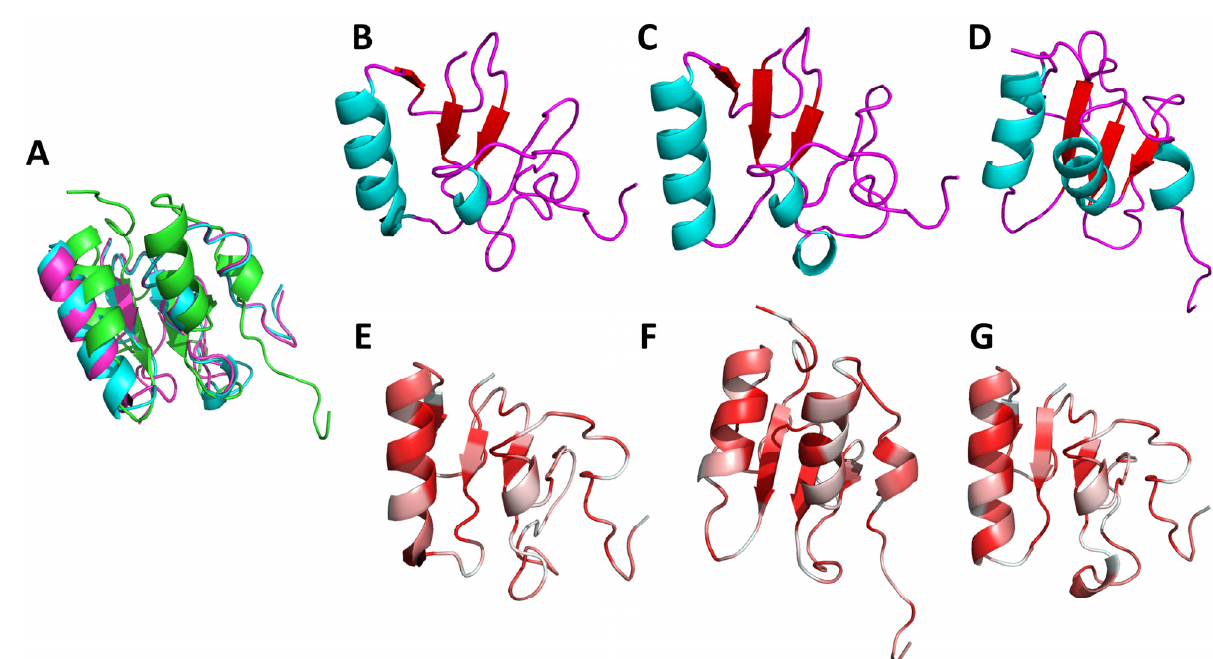
Figure 2. Selected Lmj_04_BRCT models secondary structure and hydrophobic regions. Ribbon representation of ( A ) aligned models (green: SwissModel_2, pink: Mult1_lig, cyan Mult1_lr); ( B ) Mult1_lig; ( C ) Mult1_lr; ( D ) SwissModel_2. Colors represented secondary structure elements: Red: β -sheets. Cyan: α -helixes. Pink: loops. Usual BRCT hydrophobic core of β -sheets trapped between α -helixes in a β 1, α 1, β 2, β 3, α 2, β 4, and α 3 disposition is only moderately represented in the constructed models as only the Mult1_lr model folded into these expected β 2 sheet and α 2 helix whereas expected β 4 was only present in SwissModel_2. Ribbon representation of ( E ) Mult1_lig; ( F ) Mult1_lr; ( G ) SwissModel_2. Higher intensity of red color represented higher hydrophobicity. Conventional BRCT hydrophobic clusters ( β 1, α 1 and α 1- β 2 loop, β 3 sheet, α 3 helix, and C-terminal region) were also found in the constructed models.